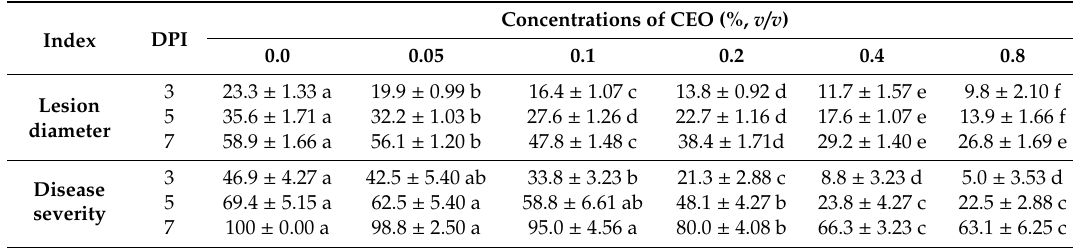
Table 2. Lesion diameter and disease severity evolution in citrus fruit treated with di ff erent concentrations of clove essential oil (CEO) infected with P. italicum at di ff erent days post inoculation